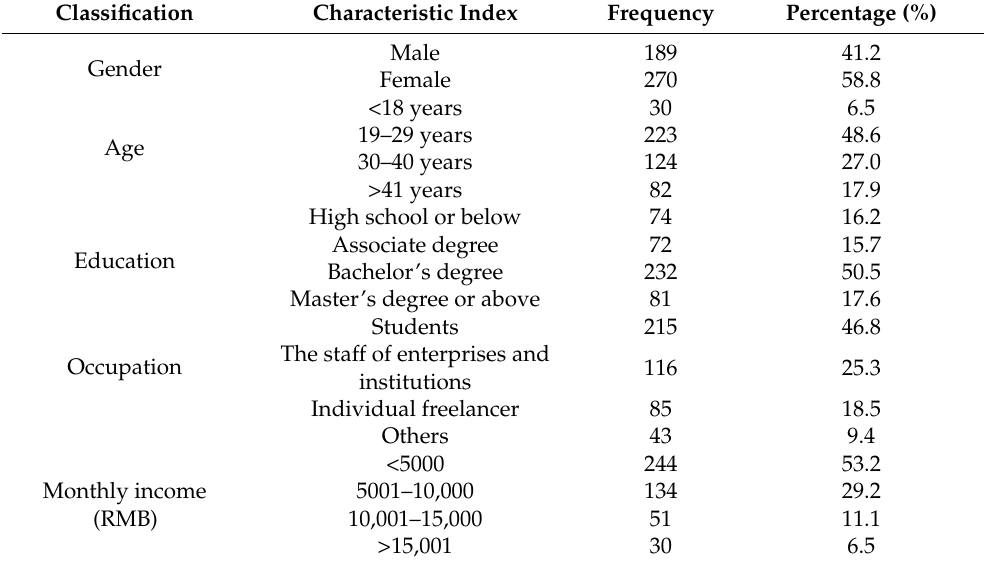
Table 1. Demographic characteristics of the